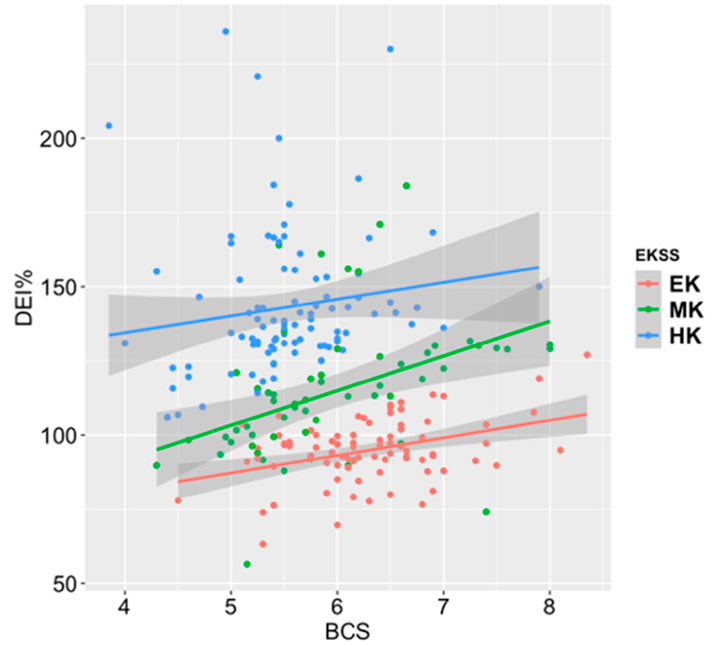
Figure 3. Linear models of DEI% and BCS for the three keeper groups. Shading indicates 95% confi- dence intervals. Easy keeper (EK) = red, Medium keeper (MK) = green, Hard keeper (HK) = blue.